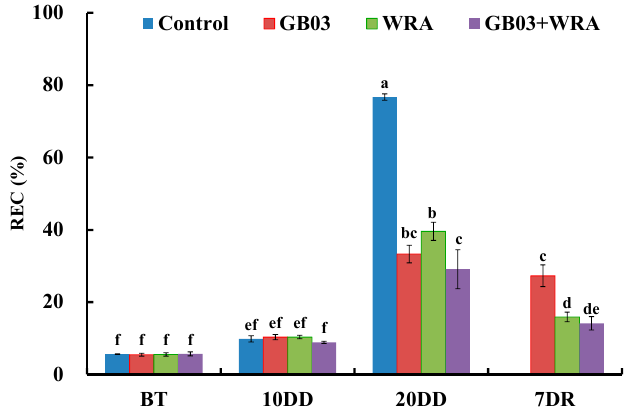
Figure 6. Effects of GB03, water retaining agent (WRA), or the combination of GB03+WRA on relative electric conductivity (REC) of ryegrass. BT, before treatment (20-day-old seedling); 10DD, 10-day natural drought; 20DD, 20-day natural drought; 7DR, 7 days after rewatering Values are means and bars indicate SEs ( n = 12). Columns with different letters indicate significant differences among treatments at p < 0.05 (ANOVA and Duncan’s post-hoc multiple comparison test).